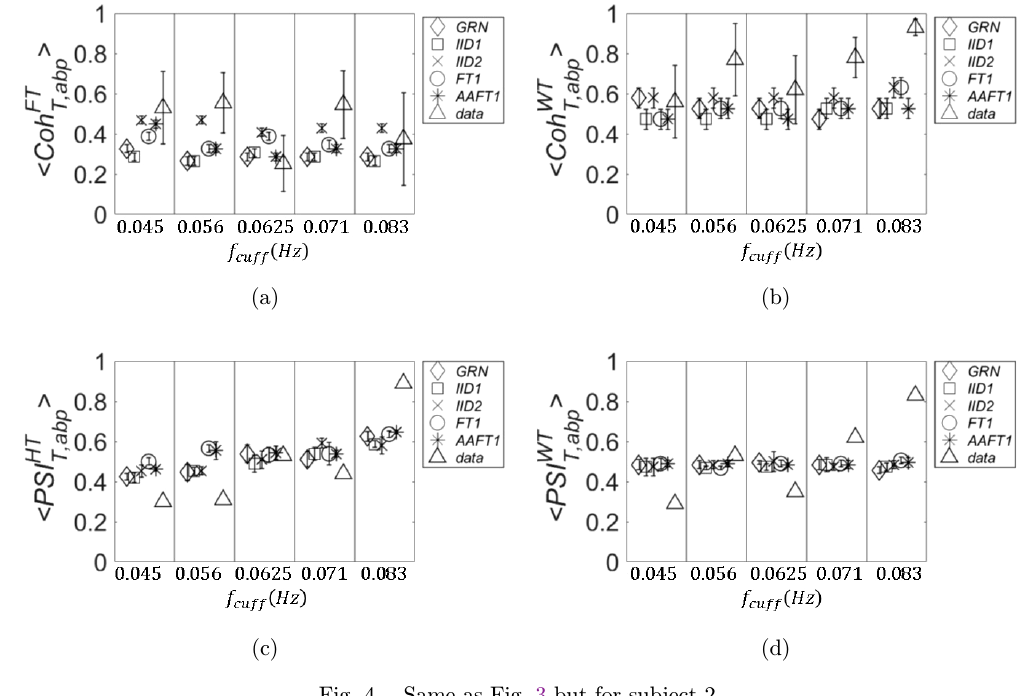
Fig. 4. Same as Fig. 3 but for subject 2.